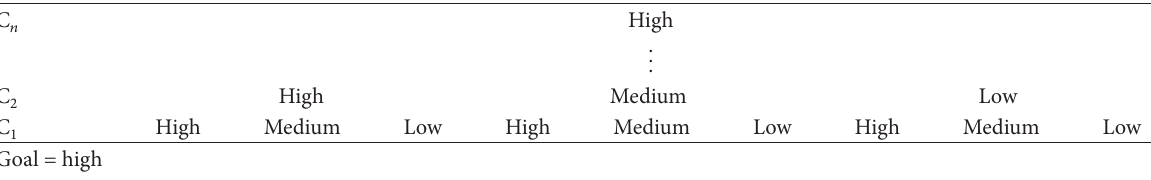
Table 3: Structure of node probability table.